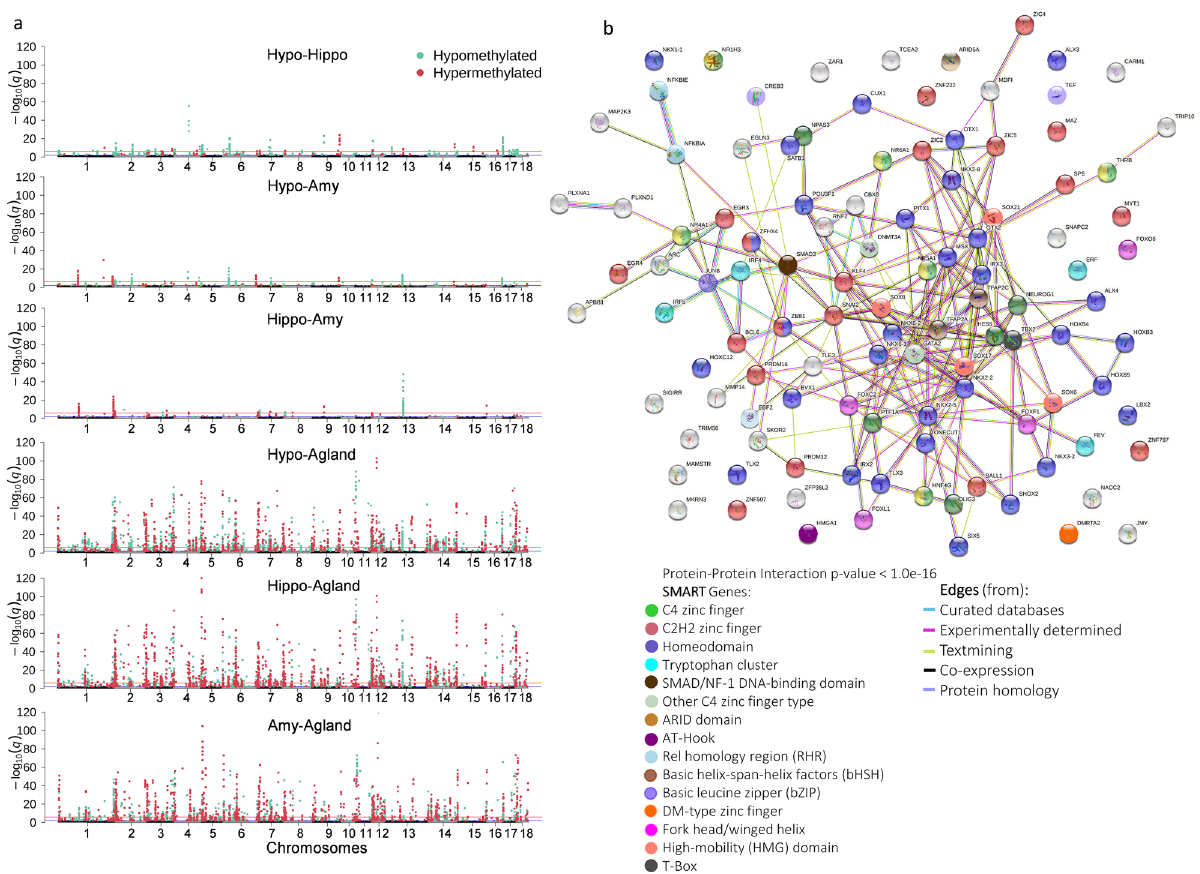
Figure 2. DMCs landscape across Hypo, Hippo, Amy, and Agland. ( a ) Manhattan plots showing pairwise differentially methylated CpGs. Statistical significance set as −log10(q-value) in the y-axis against chromosomes (autosomes) in the x-axis. Significant DMC (q-value < 0.01) are shown in colored dots, hypermethylated (light red), and hypomethylated (light cyan). Genome-wide significance levels are shown horizontal solid lines: − log10(1e-2)(dark blue) and −log10(1e-6)(dark red). ( b ) Protein–protein association STRING network 56 built using 59 (TF and co-regulators) with at least one DMC among Hypo, Hippo, Amy, and Agland (See Materials and Methods). The full network is shown, disconnected nodes are shown to reveal GRFs whose interaction is not well documented or yet unknown. The network provides discriminatory information between DNA- binding regulators (TF, in multiple colors) and other gene regulators (light grey). Color code shows different classes of DNA-binding TFs based on class, the nodes represent genes, and their color reveals their respective TF class based on Wingender et al. (2018) classification 62 . The color of the edges denotes the type of evidence that supports the interaction between pairs of